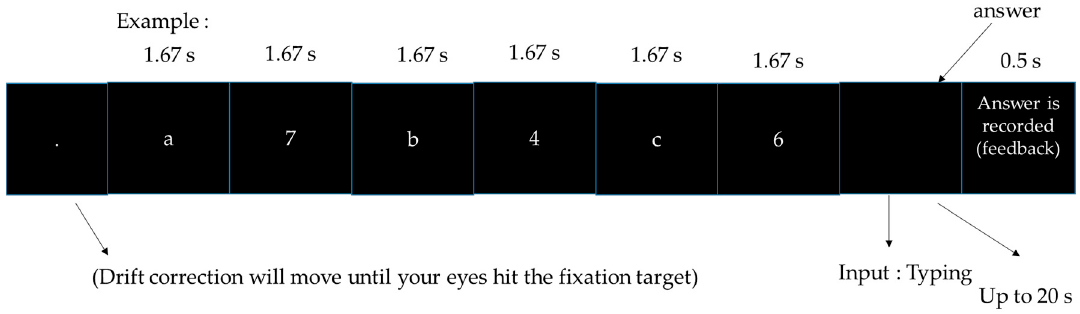
Figure 3. Figure 3. Arithmetic. Figure 3. Arithmetic.